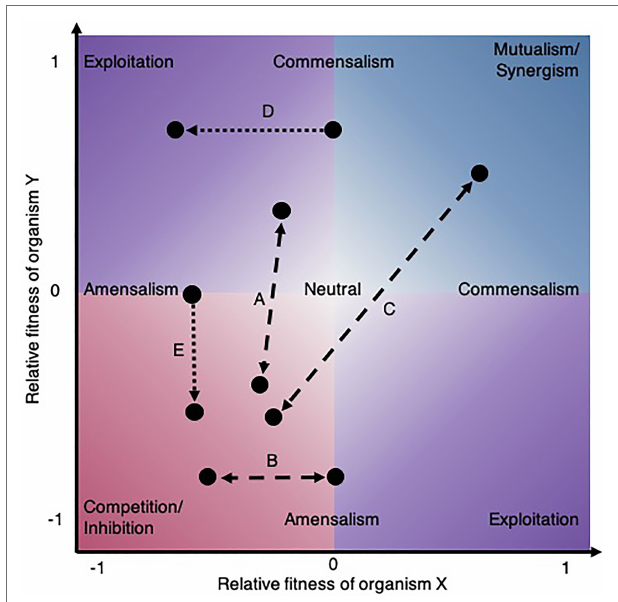
FIGURE 1 | Shift in microbial ecological interactions. The environmental context can change the ecological interactions between species (dashed lines). (A) For instance, the interaction between lung bacteria was shown to switch from exploitation to competition in response to a carcinogenic compound (Liu et al., 2017). (B) Changes in nutrients alter ecological interaction outcomes as demonstrated for Acinetobacter johnsonii and Pseudomonas putida , fluctuating between amensalism and competition depending on the carbon source provided (Rodríguez-Verdugo et al., 2019) or (C) by the ammonia concentration switching cooperation to competition between an alga and a fungus (Zuñiga et al., 2019). Evolution also leads to shifts in ecological interaction between species (dotted lines). (D) For example, a commensal interaction between two bacteria evolved into exploitation in a two-species biofilm (Hansen et al., 2007) and (E) an amensal interaction between a yeast and a bacterium rapidly evolved into inhibition (Andrade-Dominguez et al.,